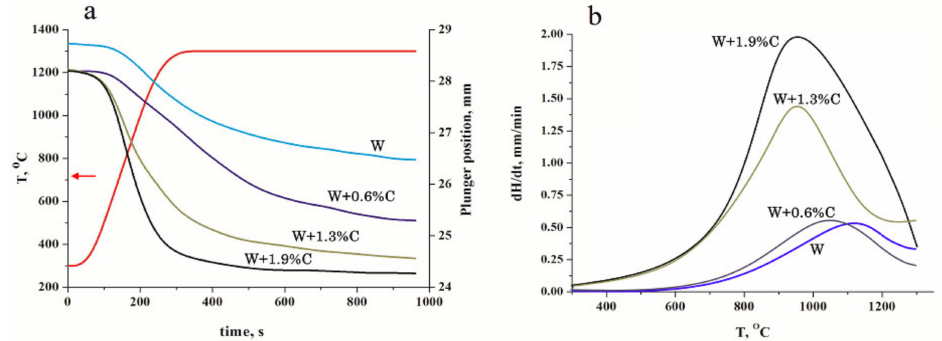
Figure 4. Sample heights ( a ) and the charge densification speed ( b ) vs. sintering time and temperature for tungsten powder with different content of carbon.